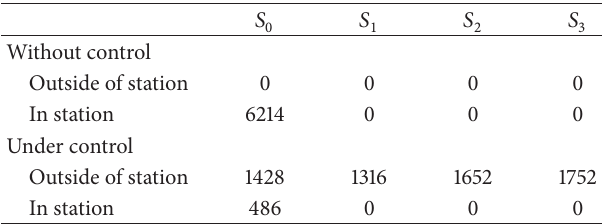
Table 6: Comparison of maximum number of passenger